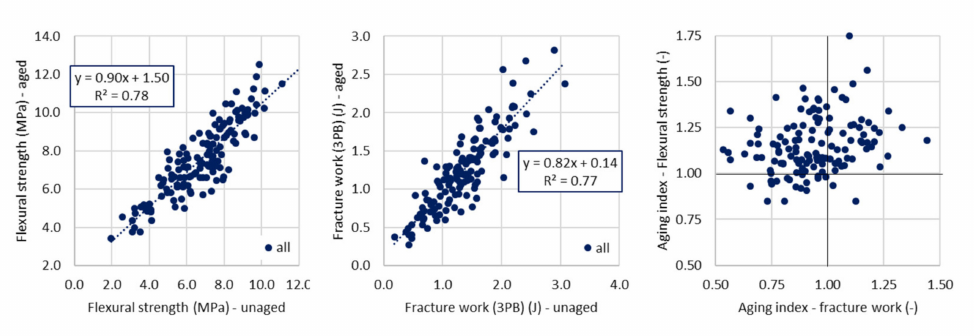
Figure 2. Comparison of aged and virgin parameters—three-point bending test ( left and middle ) and comparison of aging indexes ( right